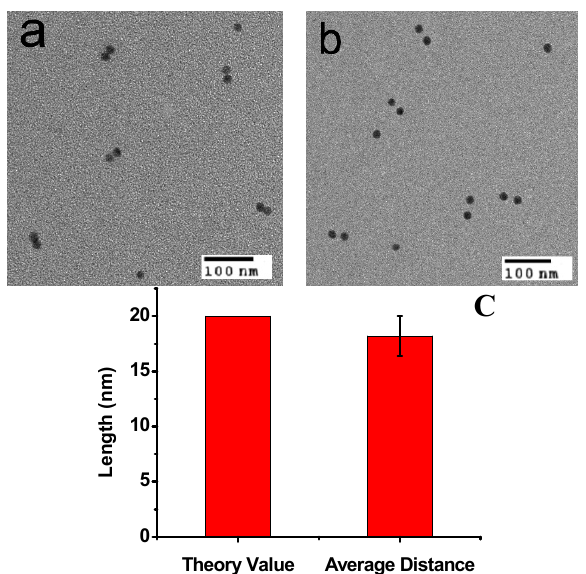
Figure 2. ( a ) TEM observation of AuNP dimers at “close” states and ( b ) AuNPs dimers at “open” states; ( c ) A histogram of the distance of the open form. The average distance was about 18.2 nm, which is coincident with the theoretical value for DNA 60 bases (~20 nm).